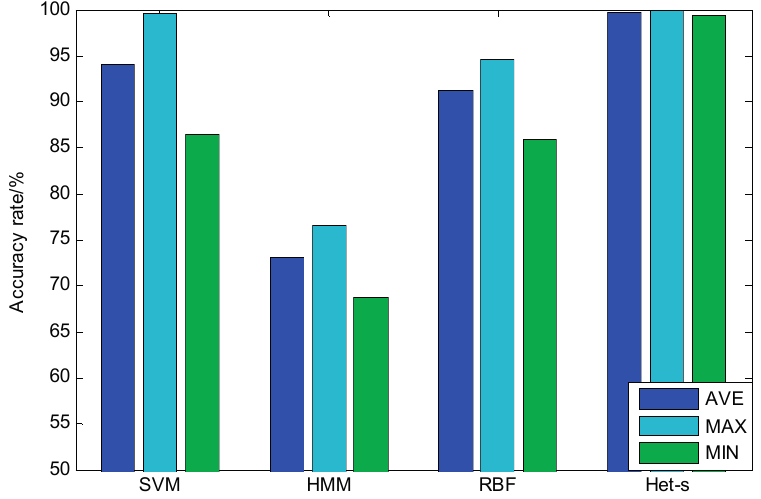
Figure 7. Comparison of single classifier with heterogeneous ensemble classifier (Het-s—heterogeneous stacking; AVE—averaging accuracy; MAX—maximum accuracy; Min—minimum accuracy).